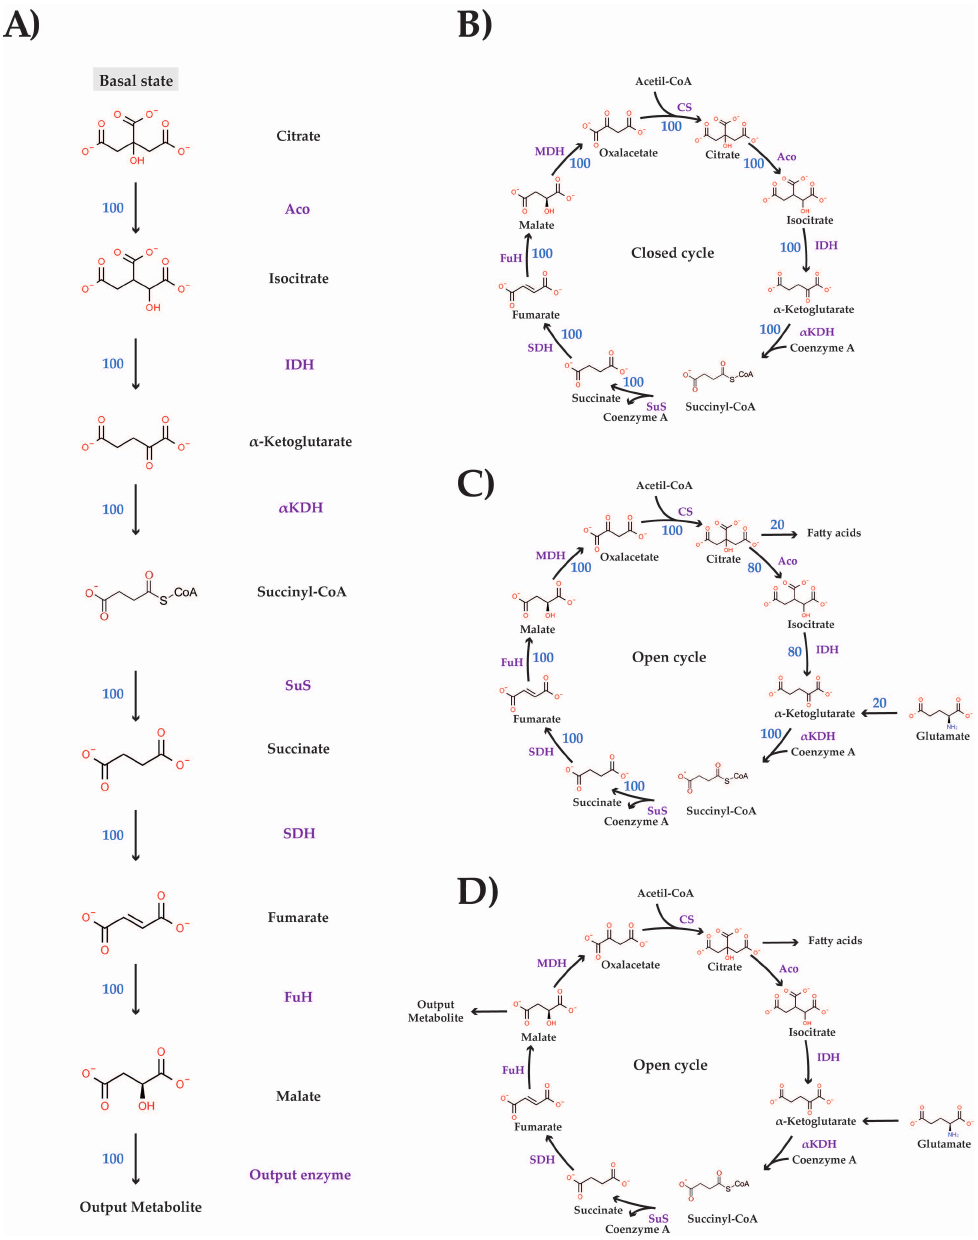
Figure 1. Models. ( A ): Linear-like Krebs’ cycle. The numbers in each arrow indicate the flux through every reaction (relative units but simulated as if they were in mmol/s). ( B ): Closed Krebs’ cycle. ( C ): Open Krebs’ cycle. One input (IF) and one output (OF) fluxes. ( D ): Open Krebs’ cycle. One input and two output fluxes. Abbreviations are: CS: citrate synthase (v1); Aco: aconitase (v2); IDH: isocitrate dehydrogenase (v3); α KDH: α -ketoglutarate dehydrogenase (v4); SuS: succinyl- CoA synthetase (v5); SDH: succinate dehydrogenase (v6); FuH: fumarate hydratase (v7); MDH: malate dehydrogenase (v8). The number near every arrow corresponds to the flux in initial (control)